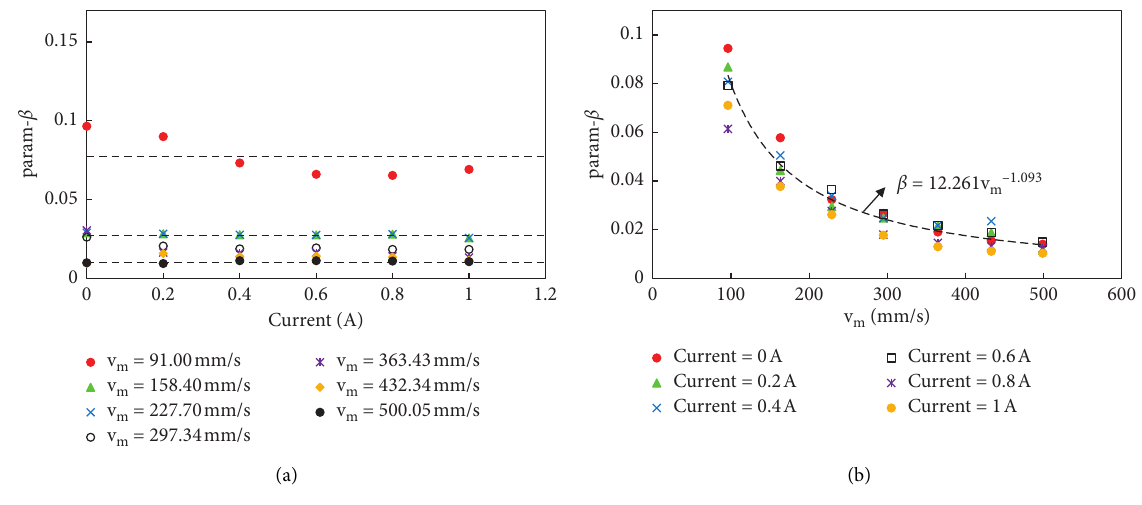
Figure 15: Identification results of parameter β